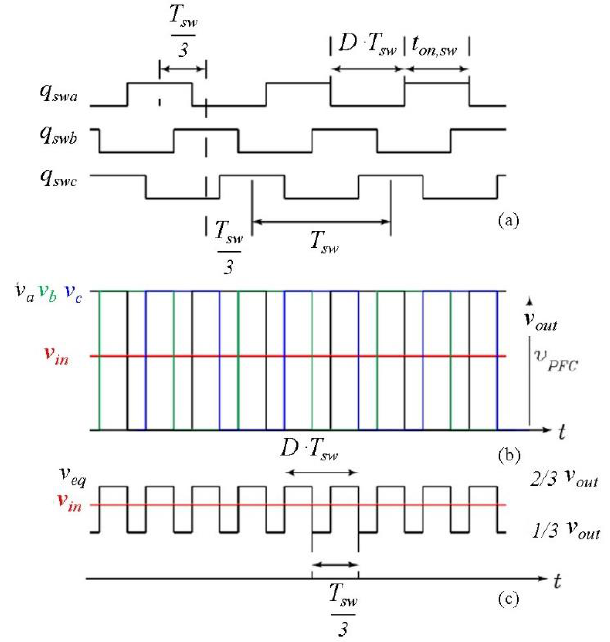
Figure 4. The qualitative waveforms for 1 / 3 < D < 2 / 3. ( a ) The device control signal, ( b ) the devices switching voltage, ( c ) the equivalent voltage behavior.